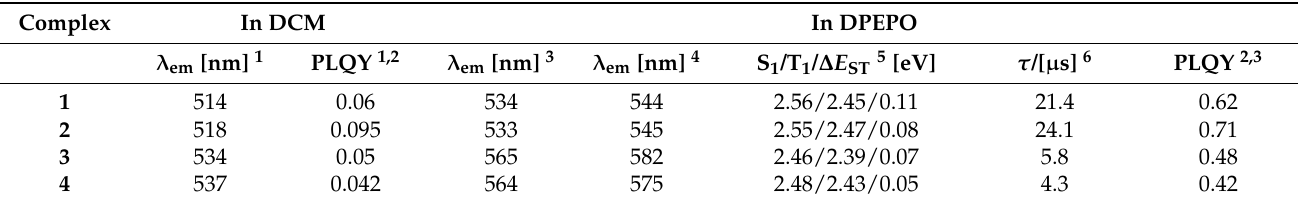
Table 1. The photophysical properties of complexes 1 – 4 .